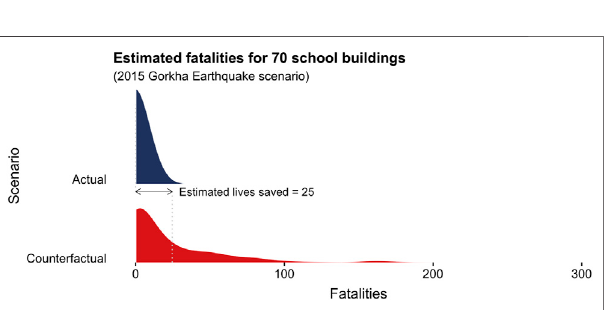
FIGURE 5 | Distribution of estimated fatalities from the 2015 M w 7.8 Gorkha earthquake based on earthquake intensity values from Chen and Wei (2019). Two scenarios are shown: the actual scenario where all 70 school buildings were retro fi tted prior to the 2015 Gorkha earthquake, and a counterfactual scenario where the schools were not retro fi tted. Our analysis show an estimated 25 lives saved in the 70 retro fi tted schools.